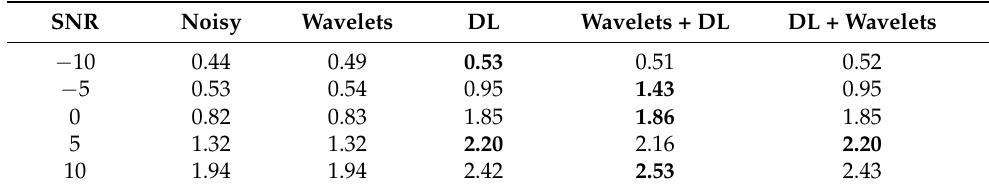
Table 1. Babble noise PESQ. The higher values represent better results. In bold is the best result for each SNR level.